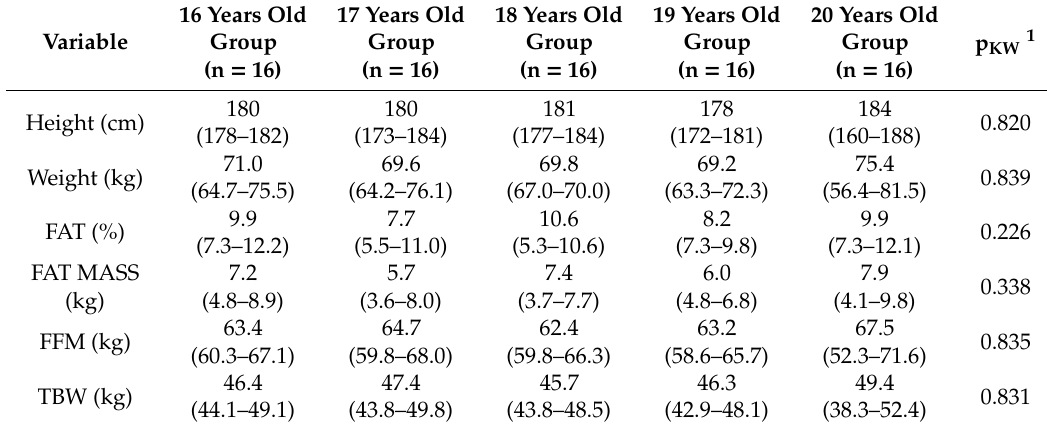
Table 2. Baseline characteristics of the